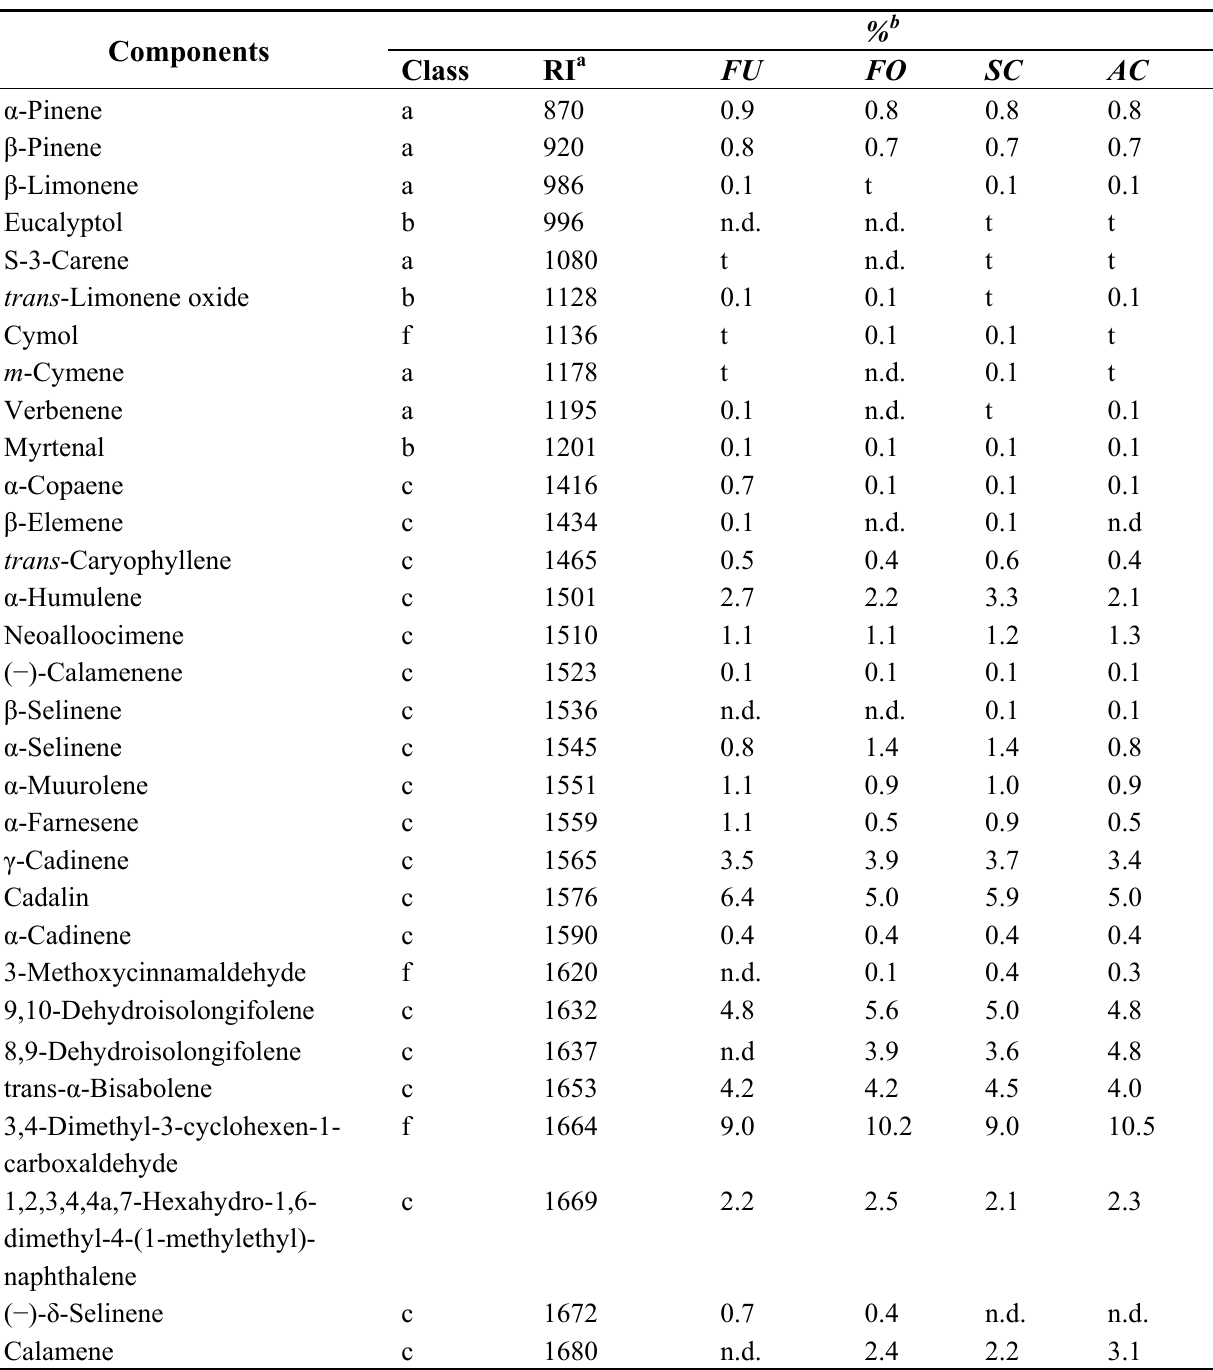
Table 1. Composition (%) of the essential oils from H. gardnerianum mature leaves obtained by